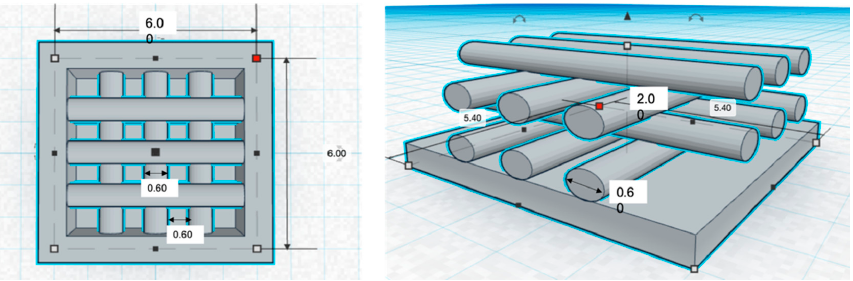
Figure 2. Computer aided design (CAD) drawing of the three dimensional (3D) printing square and design specifications.